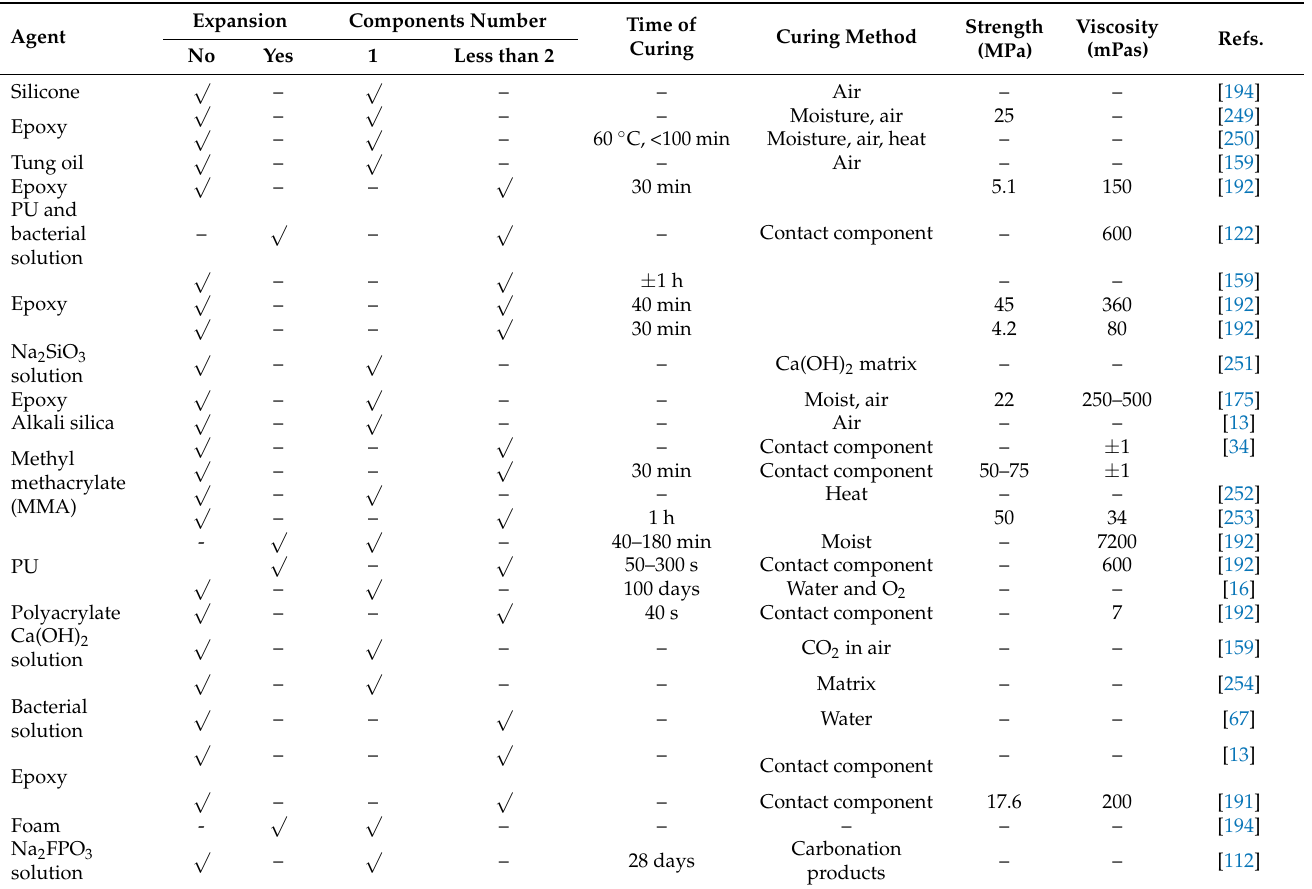
Table 7. Summary of the healing agents based on previous